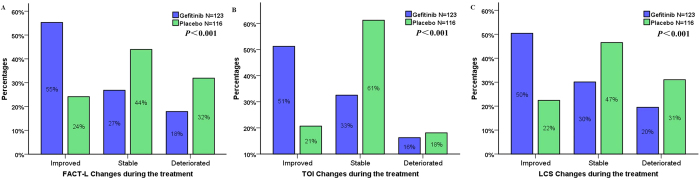
The proportion of patients with different quality of life (QoL) change during the treatment accodring to the results of FACT-L(A), TOI (B) and LCS (C). The change in QoL score were analyzed for patients with a baseline and at least one post-baseline QoL assessment (123 in gefitinib arm and 116 in placebo arm). The improvement ratios in gefitinib arm were significantly higher than placebo arm.